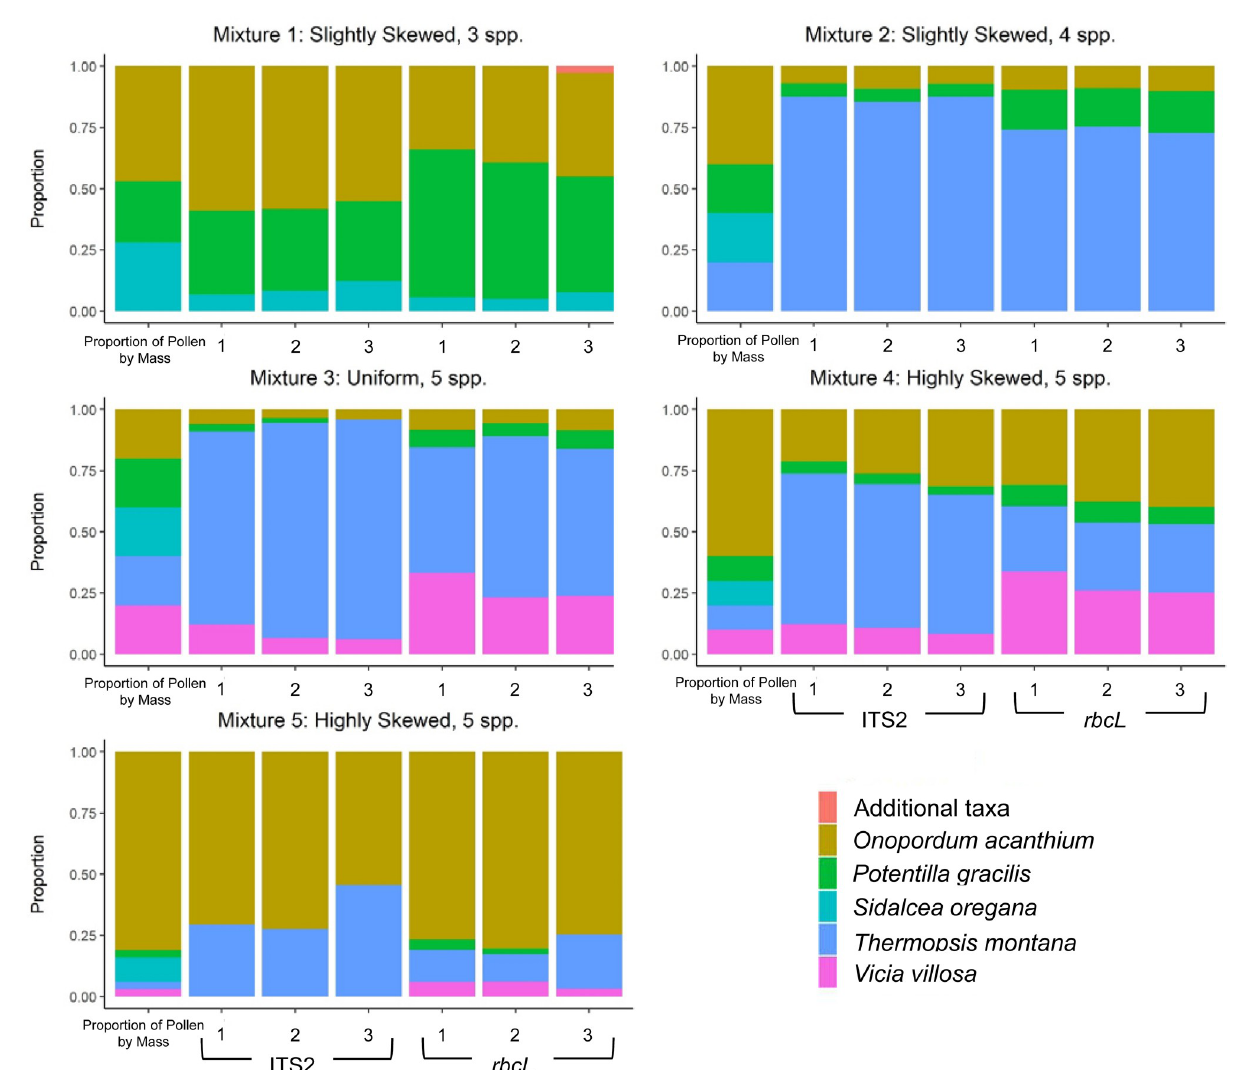
Fig 3. Actual proportion of pollen by mass vs. proportion of sequencing reads using the conservative threshold. The first column of each graph shows the actual proportion of pollen by mass for each plant species in the mixture and the following six columns show the proportion of sequencing reads produced for each species for each of three replicates per mixture obtained with DNA metabarcoding for ITS2 and rbcL regions, respectively. For ITS2, Potentilla gracilis = Potentilla sp.; Thermopsis montana = Thermopsis rhombifolia . For rbcL , Onopordum acanthium = Hieracium sp.; Sidalcea oregana = Malva neglecta ; Potentilla gracilis = Potentilla sp.; Thermopsis montana = Thermopsis sp. See graphs in S2 Fig for liberal threshold